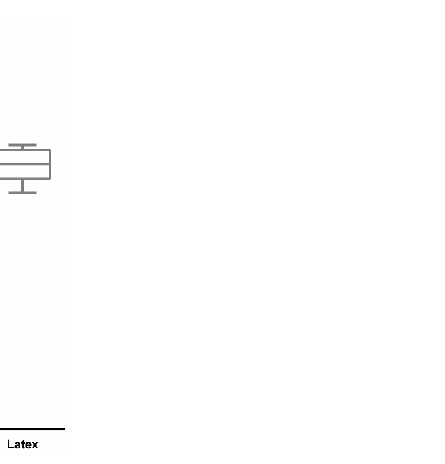
Figure 5. Weight-increase ratio after Aedes aegypti females were artificially blood-fed using different membranes. (Bars = ±SEM).